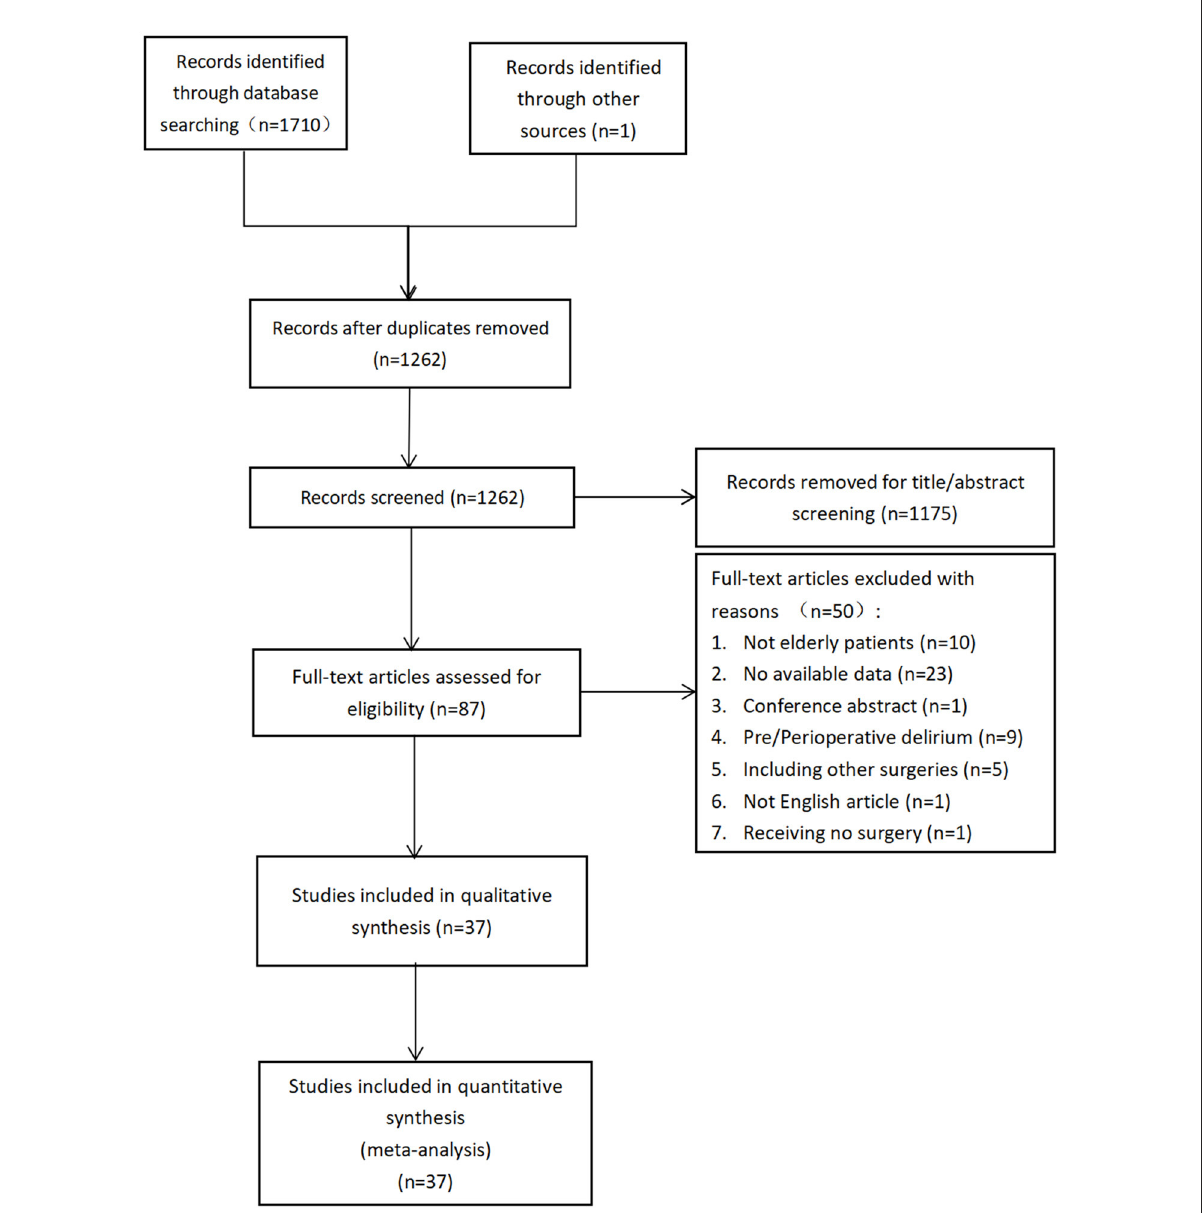
FIGURE1 The flow diagram of the search process of the literature and the result of the literature search.